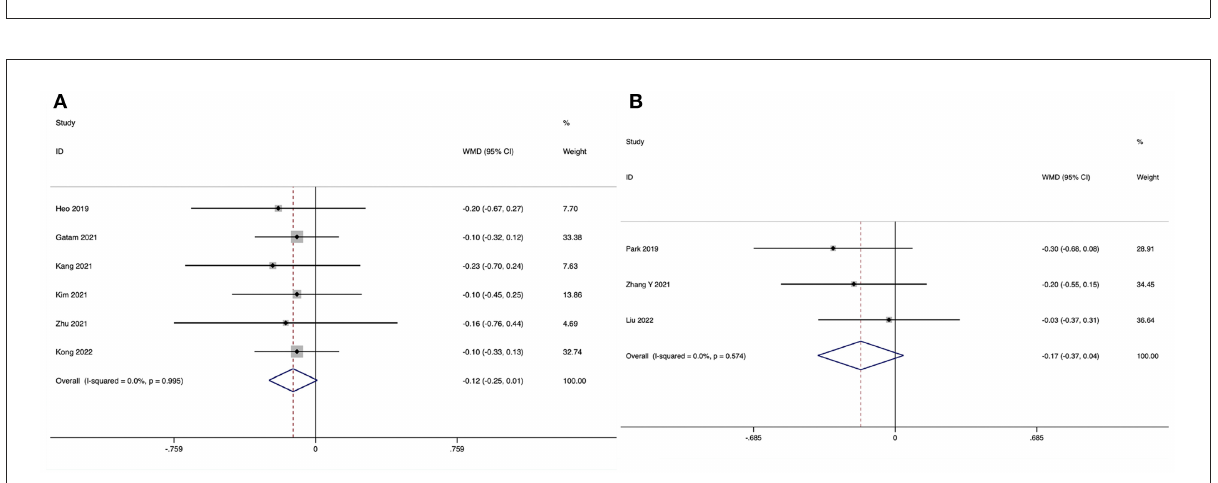
FIGURE7 Forest plot of the Visual Analog Scale score for back pain at the final follow-up. (A) ULIF vs. MI-TLIF; (B) ULIF vs. PLIF.